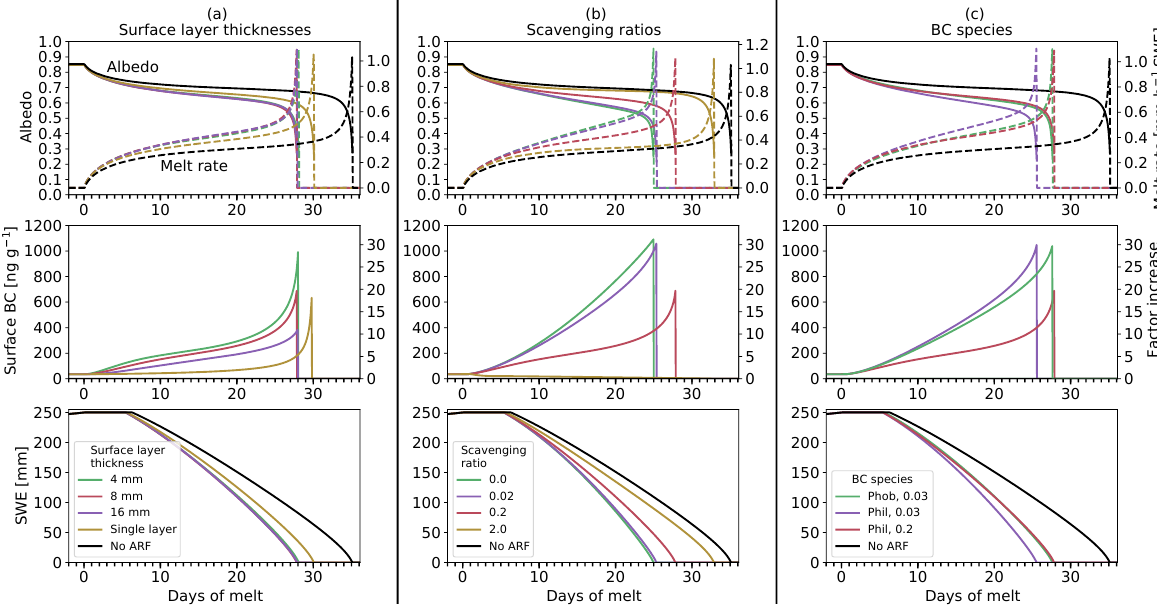
Figure 3. Snow albedo (top row of graphs; solid lines) and melt rate (top row of graphs; dashed lines), BC mixing ratio in the surface layer and factor increase in the mixing ratio during melt compared to the pre-melt BC mixing ratio (central row of graphs), and snowpack SWE (bottom row of graphs) for simulations forced with synthetic data based on average meteorological conditions during the melt season from mid March until mid July of the Atnsjoen catchment and different model configurations: (a) different values for maximum surface layer thickness; (b) scavenging ratio; and (c) BC species with different melt scavenging ratios applied ( phob and phil in the legend stand for hydrophobic and hydrophilic BC, respectively). The black lines in all graphs show simulation results of model runs without ARF applied